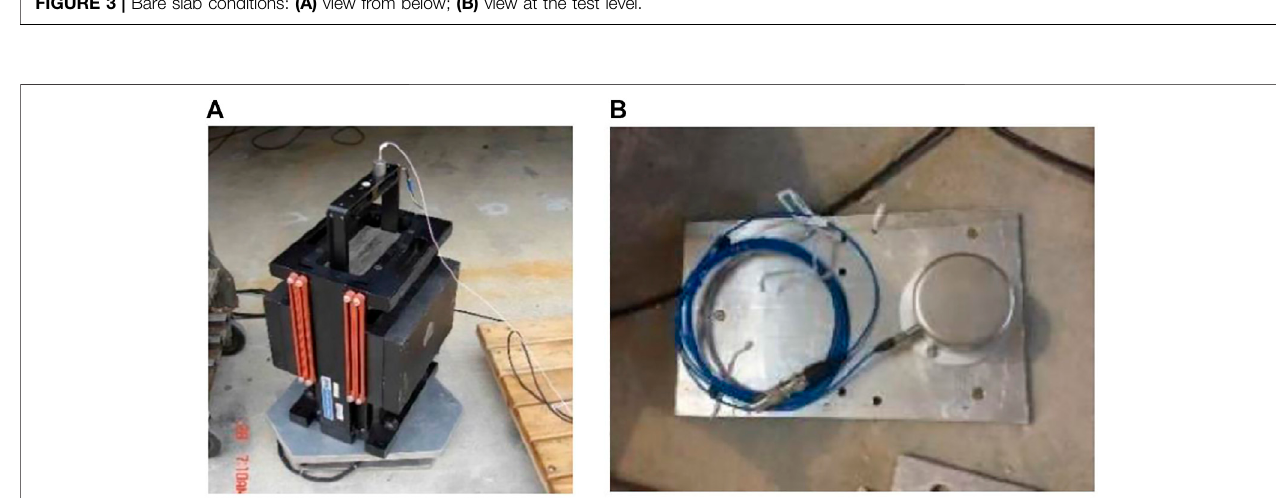
FIGURE 4 | (A) Electrodynamics shaker. (B)